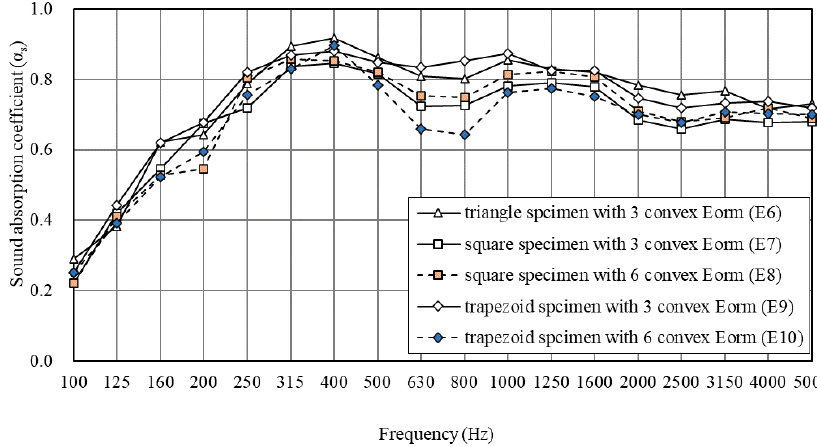
Figure 10. The sound-absorption coefficient of 80 mm FEMM with a 200 mm cavity.